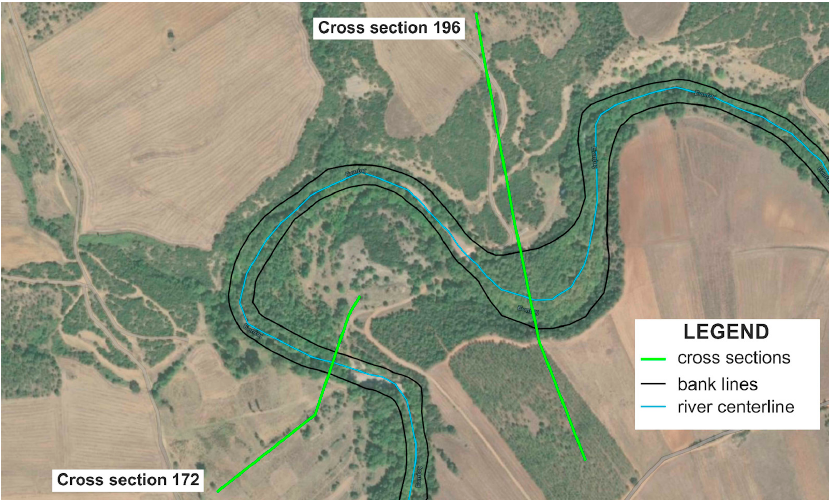
Figure 13. Exact locations of two selected cross-sections (172 and 196; see SM23) in the meandering part of the river in the “flood area”, featured in detail in Figure 14.